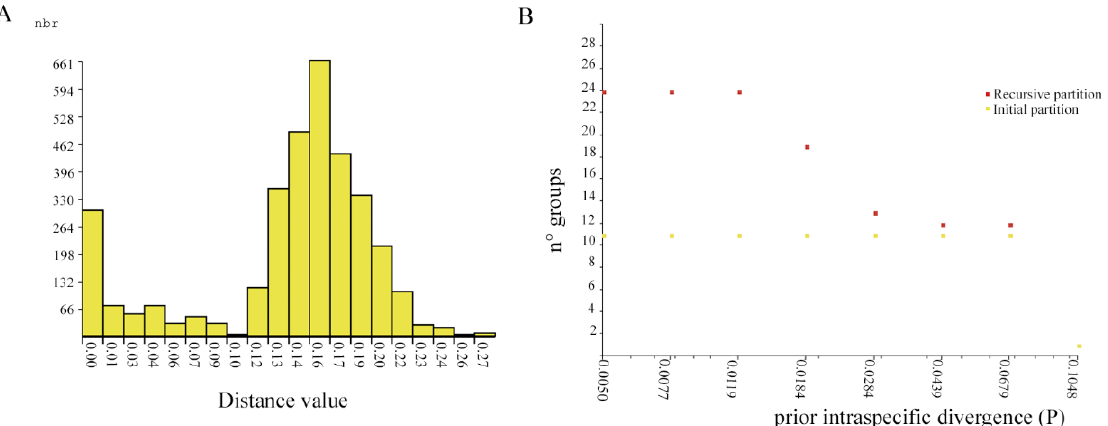
Figure 4. Results generated from ABGD method: ( A ) pairwise Jukes Cantor distances histogram. The horizontal axis shows the pairwise JC-distance, and the vertical axis shows the number of pairwise sequence comparisons; ( B ) number of OTUs with prior intraspecific divergence based on DNA barcodes of Polypedilum specimens from Ecuador, Colombia and Chile.